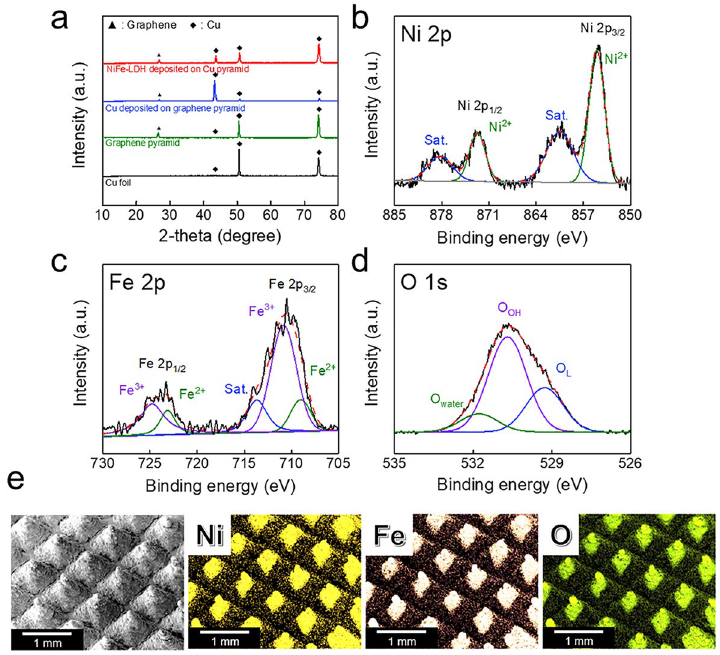
Figure 4. Physicochemical analysis of the fabricated 3D NiFe-LDH pyramid electrode. (a) X-ray diffraction pattern of the fabricated electrode: Cu-foil (black), graphene pyramid (green), Cu deposited on graphene pyramid (blue) and NiFe-LDH deposited on Cu pyramid (red). X-ray photoelectron spectra of (b) Ni 2p, (c) Fe 2p, and (d) O 1 s. (e) Energy dispersive spectrometry (EDS) mapping images of NiFe-LDH pyramid electrode: Ni (yellow), Fe (apricot), and O